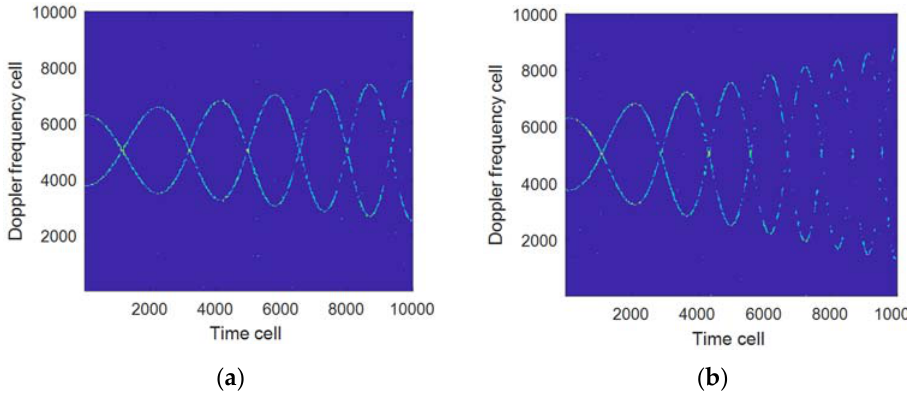
Figure 5. Processed results when rotation frequency changes. ( a ) When rotation frequency variation is 1 Hz/s ( g ); ( b ) When rotation frequency variation is 2 Hz/s ( g W = 80